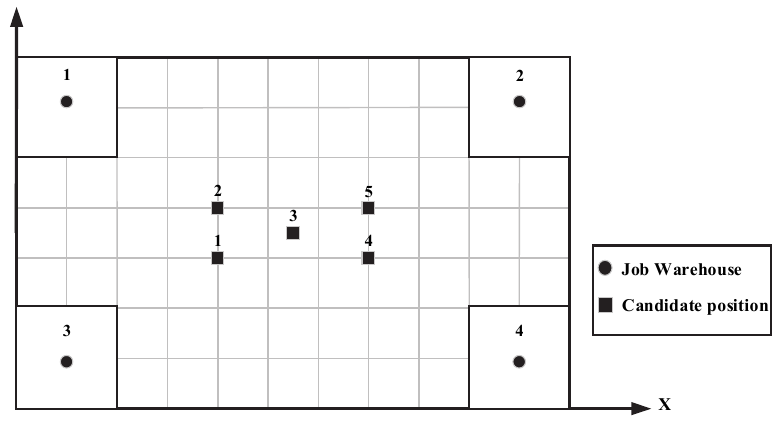
Fig. 1. The discrete parallel machine ScheLoc